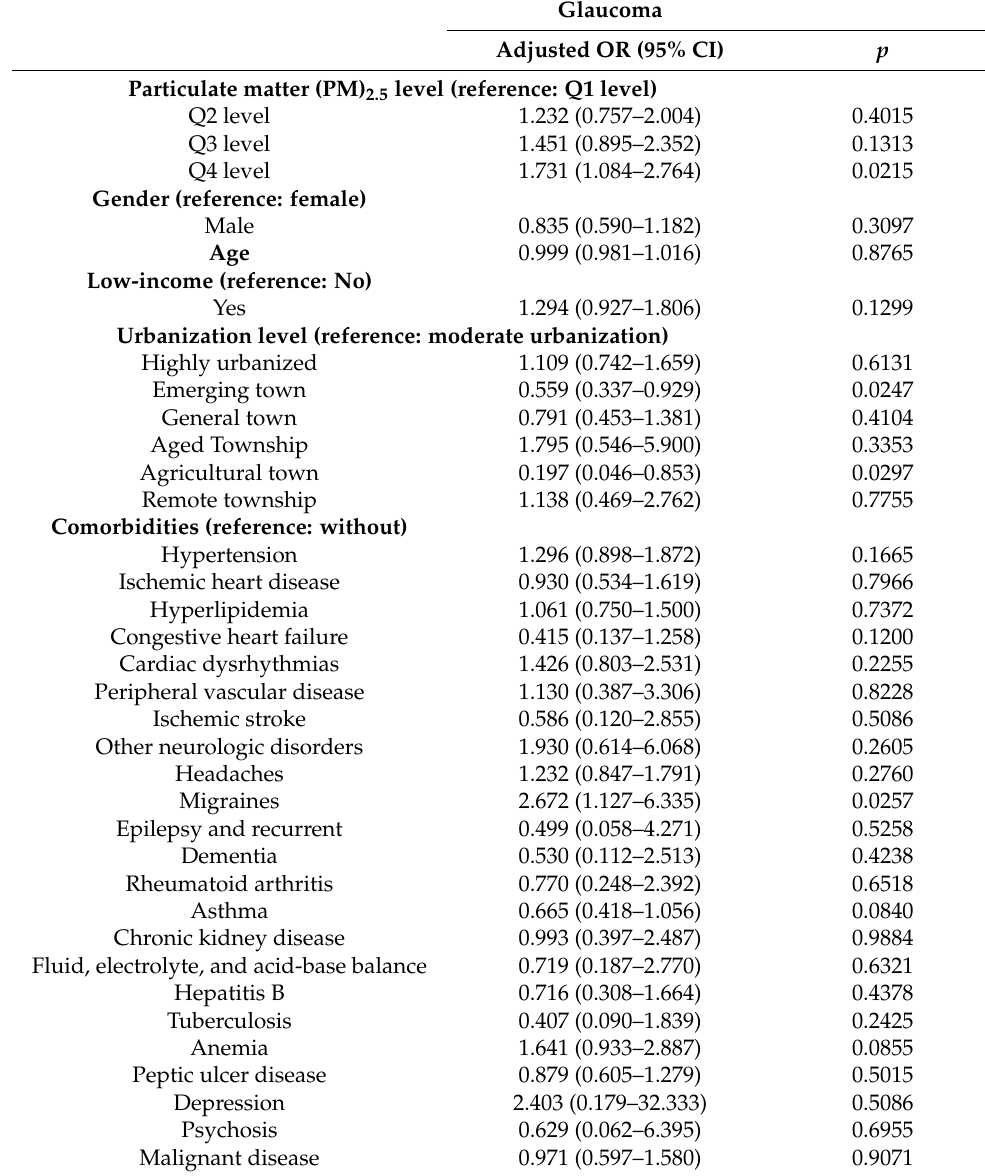
Table 2. Logic regression analysis of Particulate matter (PM)2.5 level and Glaucoma. Adjustment for gender, age, low-income, urbanization level, comorbidities. OR, odds ratio; CI, confidence